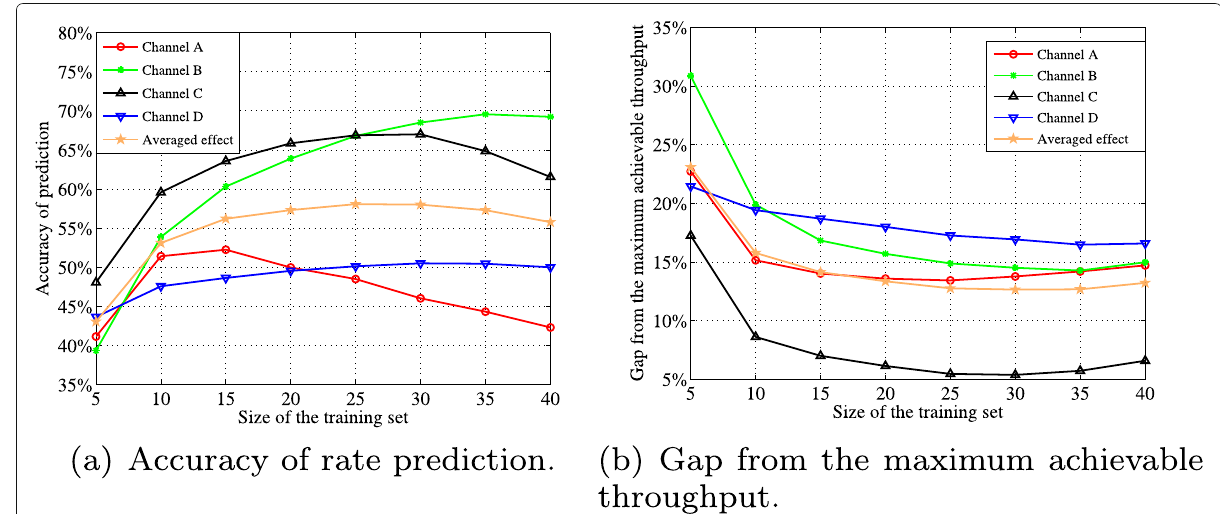
Fig. 6 Effect of training set size on rate prediction performance. a The impact of the training set size on prediction accuracy. b the impact of the training set size on throughput performance